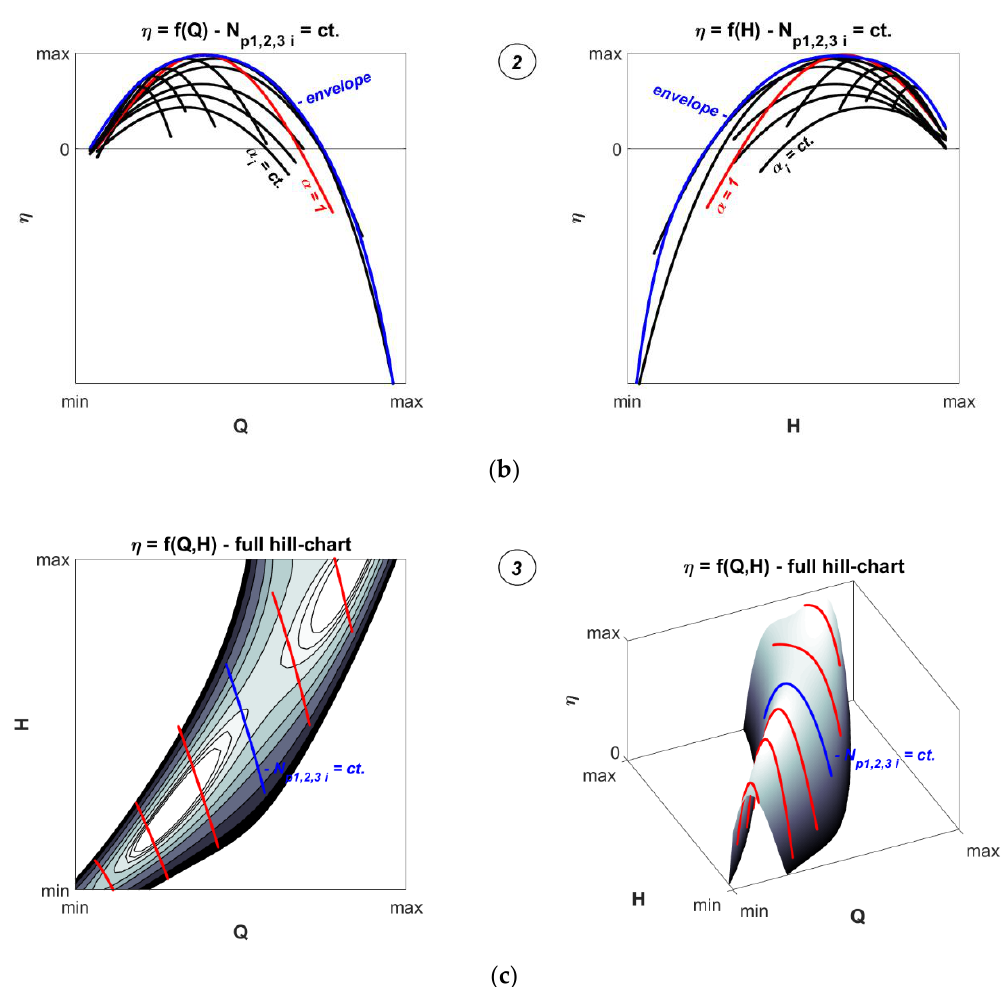
Figure 2. Employed methodology to reconstruct the full hydraulic efficiency hill-chart of a double-regulated machine using the alternative dynamic measurements method: ( a ) First step: measurements of several efficiency hill-charts at constant rotational speed N p1,2,3 i of the test rig recirculating pumps and constant speed ratio between the two runners, α i ; ( b ) Second step: calculation of discharge-efficiency and head-efficiency envelopes for all testing recirculating pumps’ speed values; ( c ) Third step: construction of the final full 3D hill-chart of the machine by surface interpolation using the previously obtained envelopes.